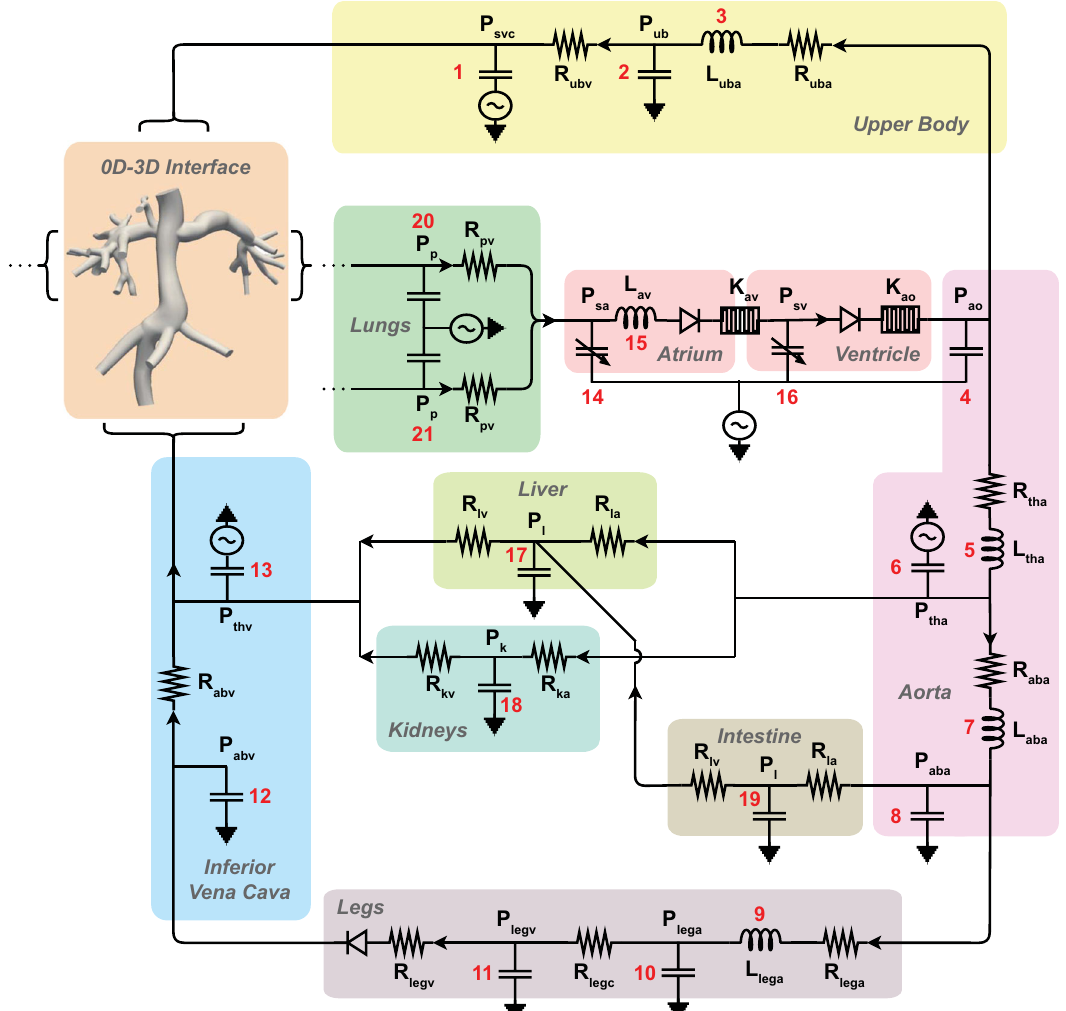
Fig. 9 Diagram of the lumped parameter network (LPN). Connections between the 0D-3D interface, resistors ( R ), capacitors ( C ), pressures ( P ), and inductor s( L ) components are